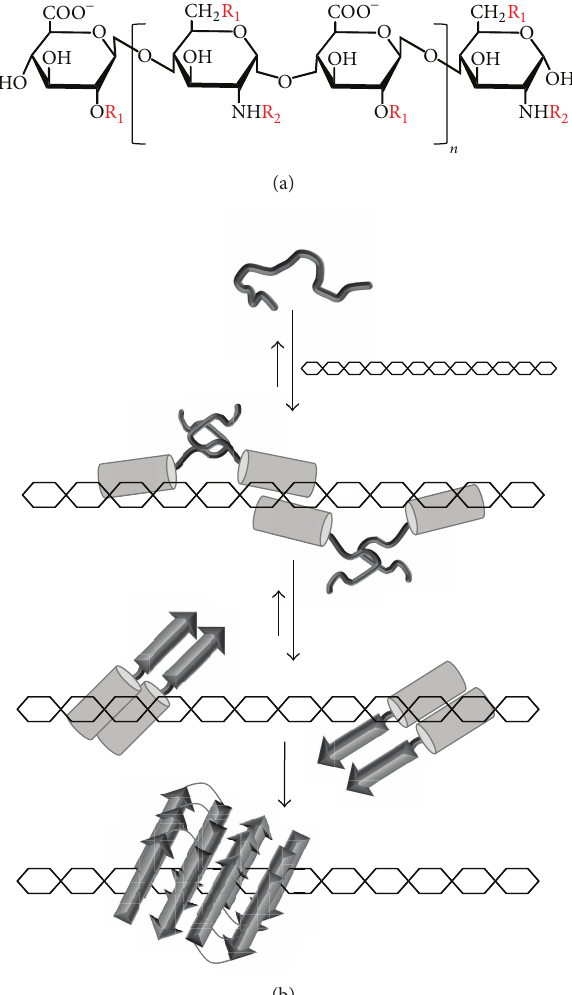
Figure 3: Roles of sulfated GAGs in IAPP amyloidogenesis. (a) Representative structure of heparin or heparan sulfate composed of glucuronic acid (GlcA) linked to glucosamine (GlcN) disaccharide repeatingsubunit.R 1 couldbe–Hor–SO 3− whereasR 2 couldbe–H, –SO 3− , or –COCH 3 . (b) Schematic representation of the postulated mechanism by which sulfated GAGs might promote IAPP